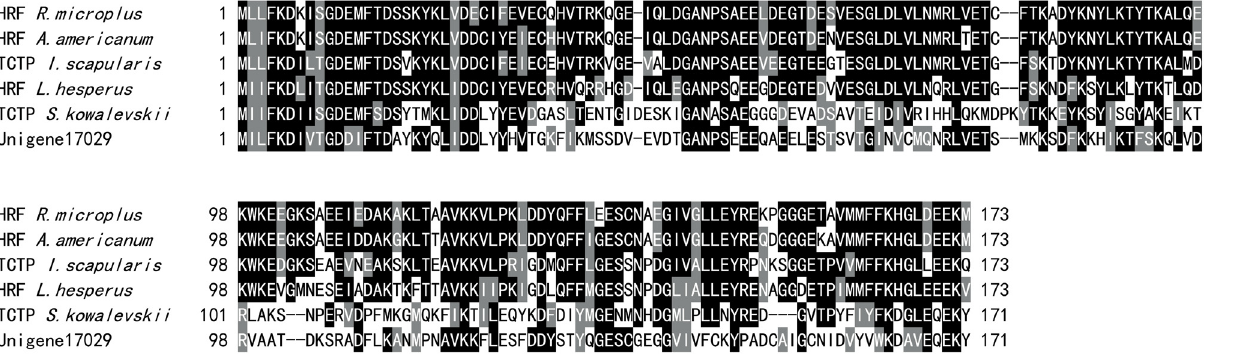
Fig 8. Alignment of translationally controlled tumor protein (or histamine-releasing factor). The aligned sequences are as follows: Rhipicephalus microplus histamine release factor (AAY67698), Amblyomma americanum histamine release factor (AAY67700), Latrodectus hesperus histamine release factor (ADV40083), Saccoglossus kowalevskii TCTP (XP_002740226) and Ixodes scapularis TCTP (AAY66972). Black and gray indicate amino acids that are identical or highly conserved across all aligned sequences,